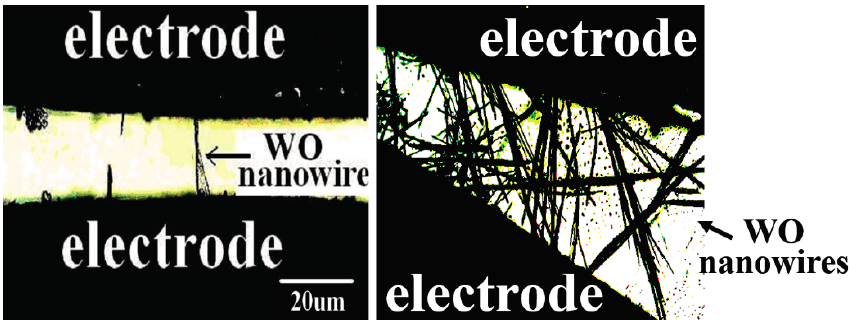
Figure 1. Microscope photograph of the architecture of the prototypical sensor where the nanowires are directly deposited onto a pair of